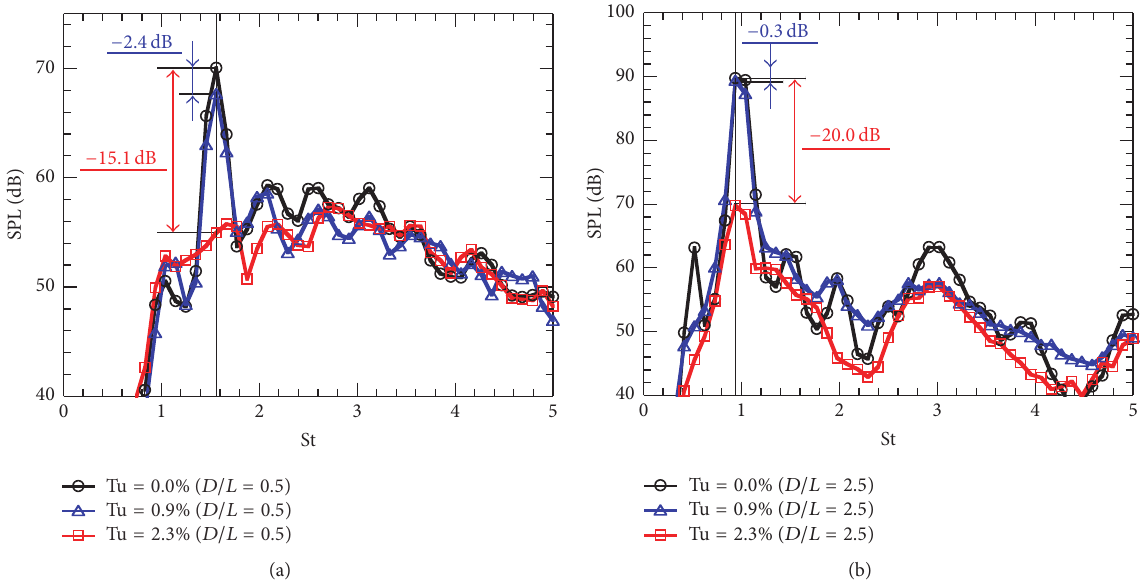
Figure 19: Sound pressure spectra ( x / L = 6.75 and y / L = 23.5) and difference in tonal sound pressure levels due to effects of freestream turbulence. (a) Cavity flow without acoustic resonance ( D / L = 0.5). (b) Cavity flow with acoustic resonance ( D / L =